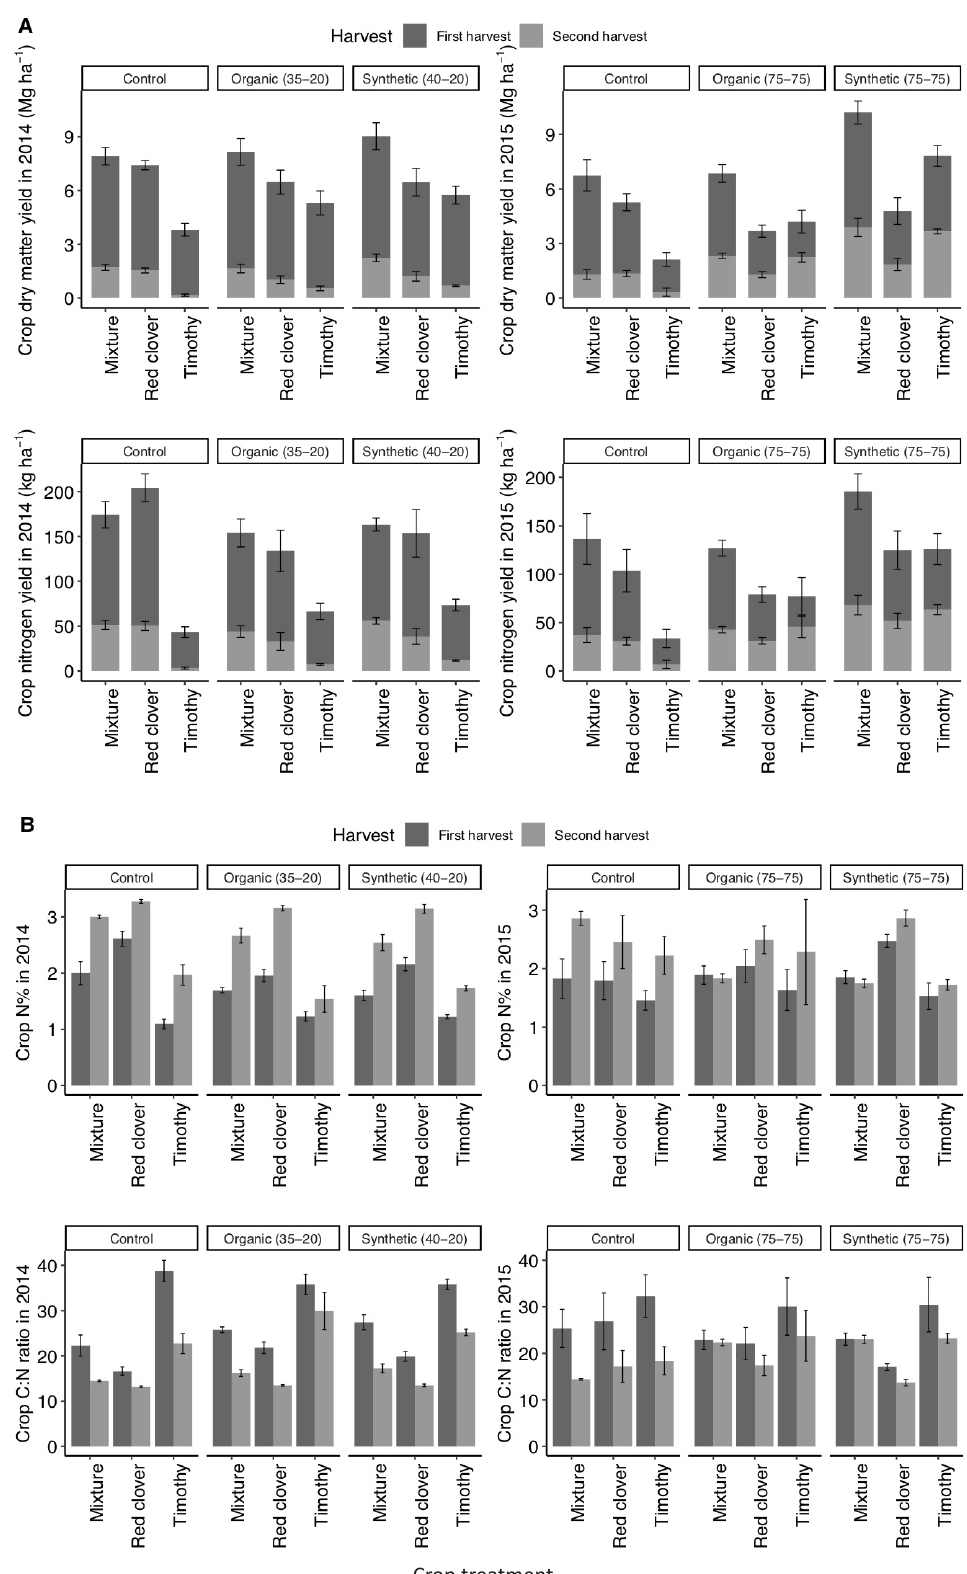
Crop Fig. 2. Crop dry matter and nitrogen yields (A) and crop N% and C:N ratio (B) under fertilizer-crop interaction. The fertilizer application rates (kg N ha -1 ) are indicated in brackets, the error bars represent the standard error of mean.